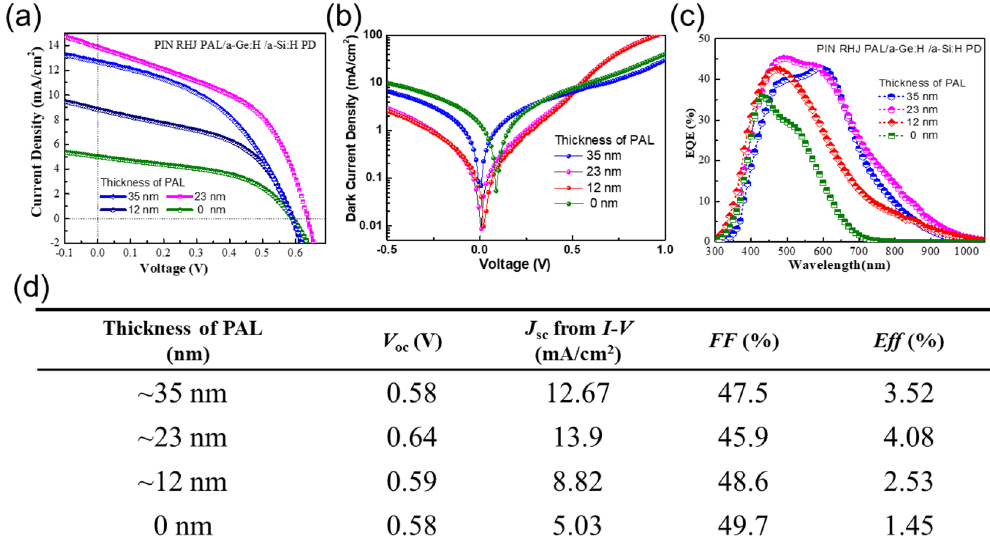
Figure 4. ( a – d ) Show the current density-voltage (J-V), IV dark characteristics, EQE curves and performance parameters of PIN RHJ PAL/a-Ge:H/a-Si:H PDs with different PAL thicknesses when fixed the a-Ge:H thickness at ~6 nm.